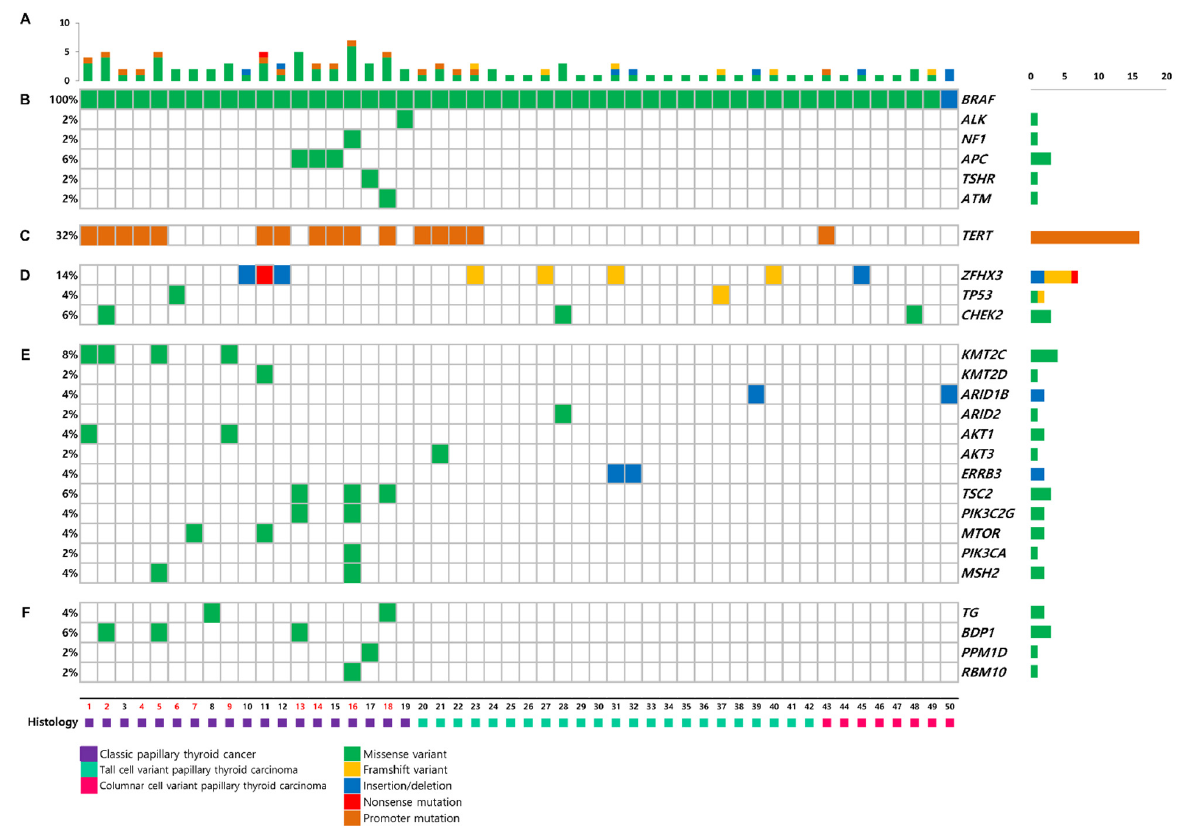
Figure 1. Mutations in 50 primary tumors of BRAF V600E -mutant PTCs. ( A ) Numbers of mutations, ( B ) driver genes, ( C ) TERT promoter, ( D ) tumor suppressor genes, ( E ) key pathways and functional groups, and ( F ) other genes. Sample numbers in red letters indicate patients who died during follow-up.